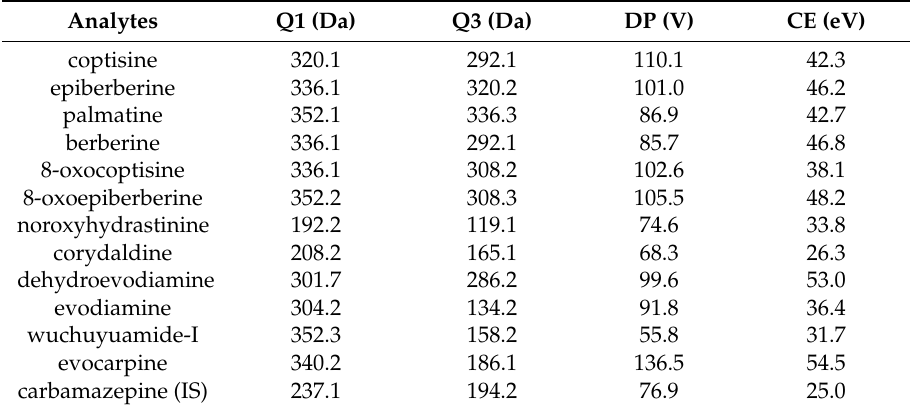
Table 5. MRM parameters of the 12 alkaloids and